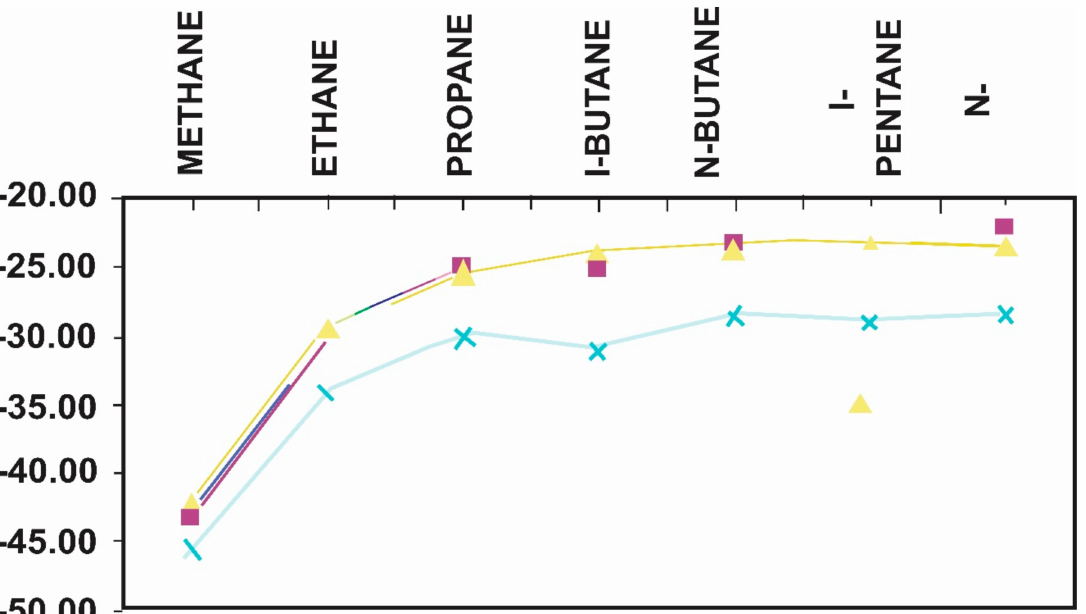
Figure 9. Diagram establishing the relationships between families of gases within a specific. Basin (after